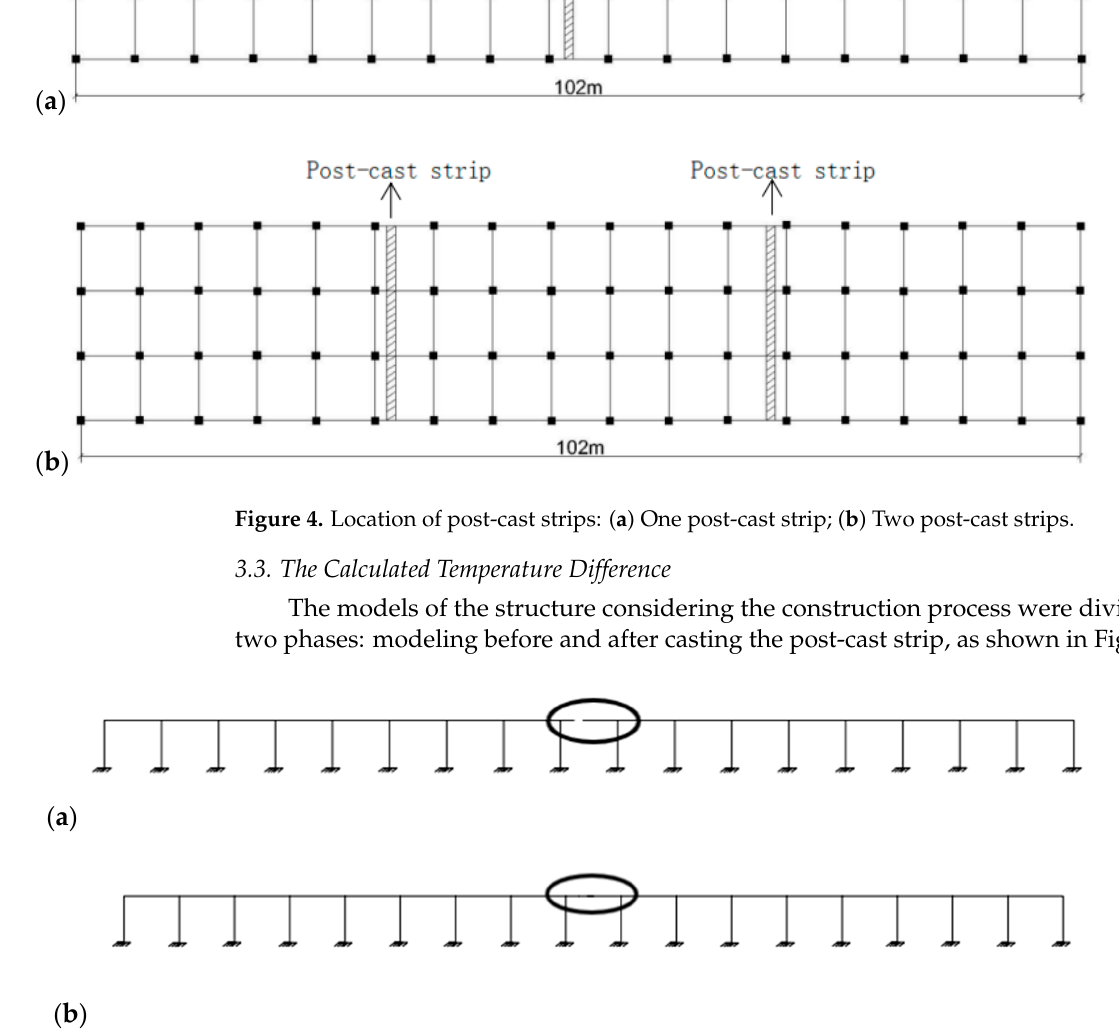
Figure 5. Modeling before and after casting the post-cast strip: ( a ) Before casting the post-cast strip; ( b ) After casting the post-cast strip.